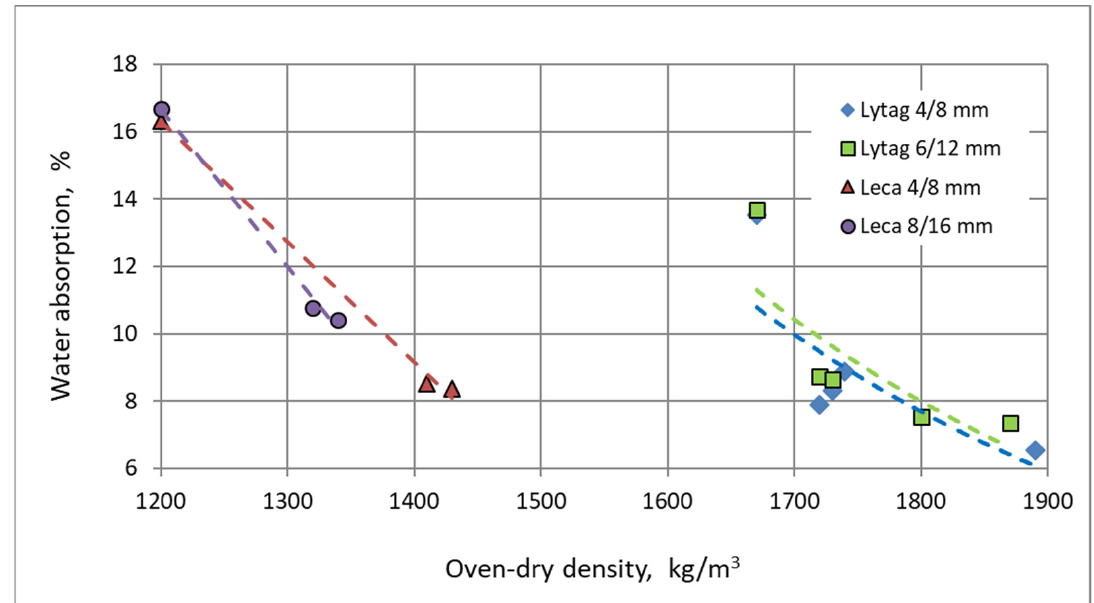
Figure 10. Relationship between mean oven-dry density of tested concretes and their mean water absorption.